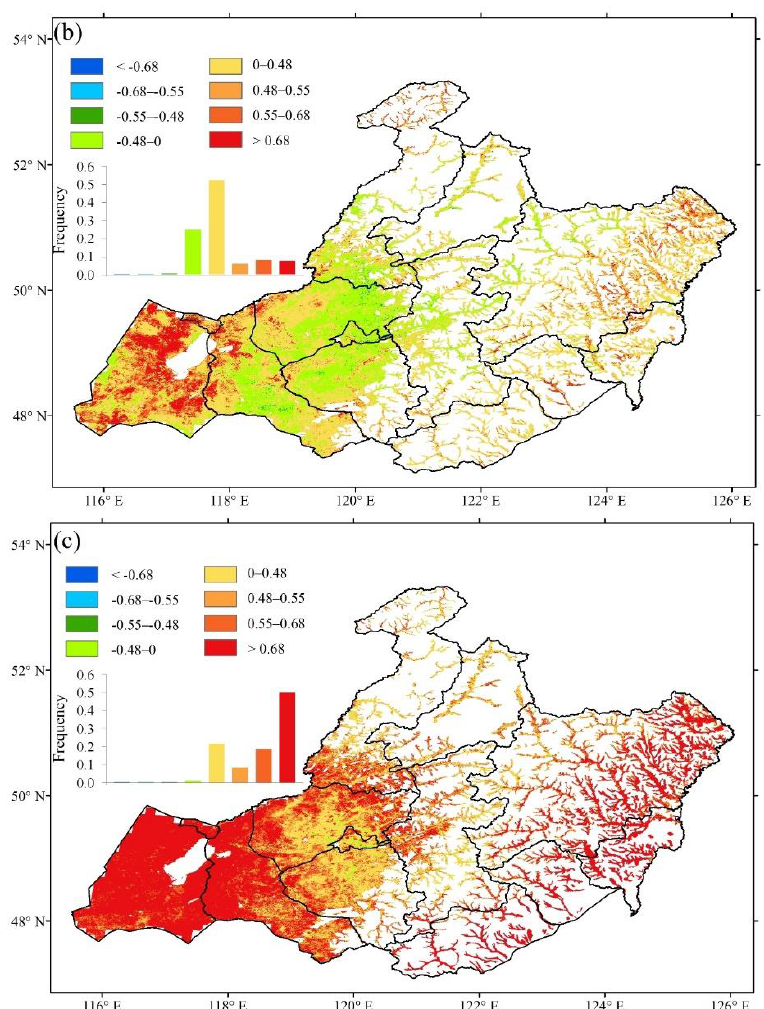
Figure 15. Spatial patterns of the interannual partial correlations between the accumulated growing degree-days requirement and chilling days ( a ), precipitation ( b ), and insolation ( c ) under the 5 °C threshold 60 days before the green-up date. Partial correlation coefficient values of ±0.68, ±0.55, and ±0.48 correspond to significance at p = 0.01, p = 0.05, and p = 0.10, respectively. Top-left insets show the frequency distributions of the correlation coefficients corresponding to the values indicated by the map legends.